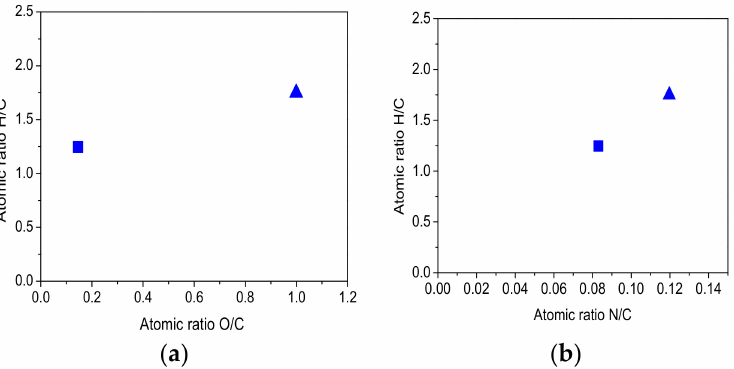
Figure 5. Van Krevelen diagram: ( a ) O/C-H/C and ( b ) N/C-H/C from N. gaditana ( (cid:78) ) and biocrude obtained under optimal conditions: 320 ◦ C, 10 min and 10% of biomass ( (cid:4) ).